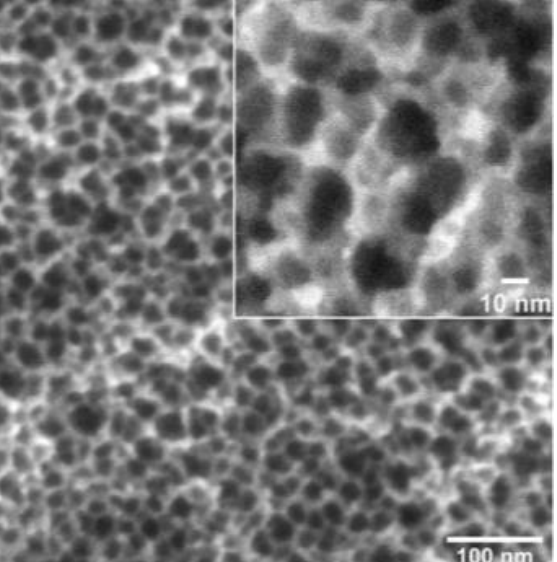
Figure 12. Nanostructure obtained in titanium meshes treated with Piranha.